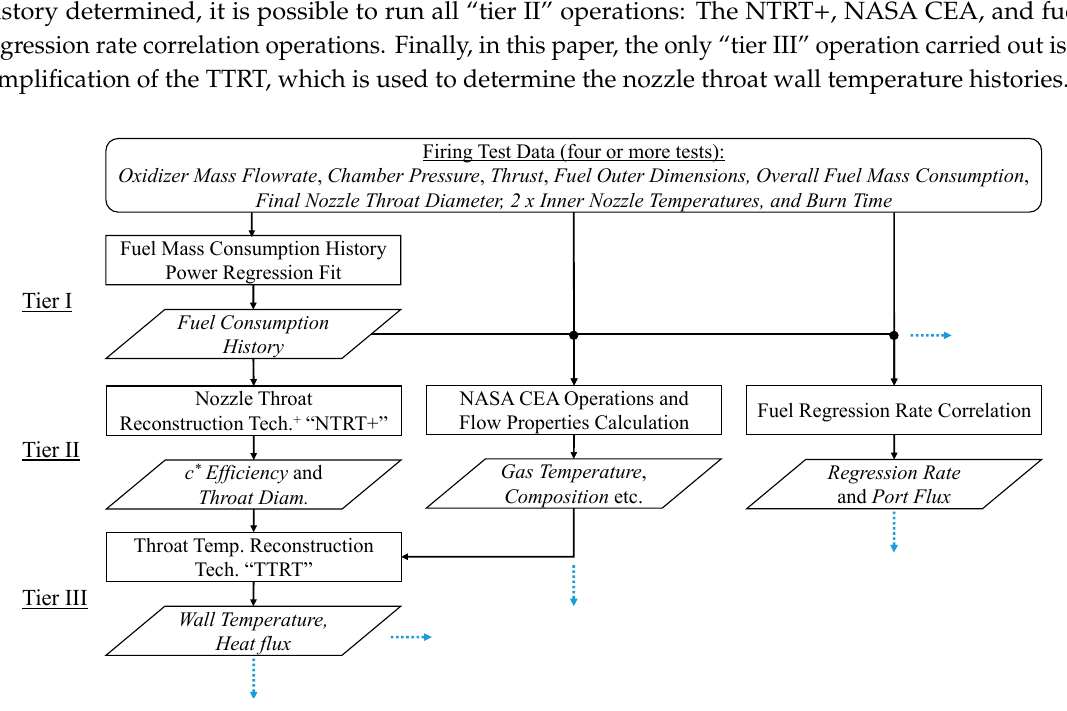
Figure 3. Flowchart of comprehensive data reduction operations in this research.